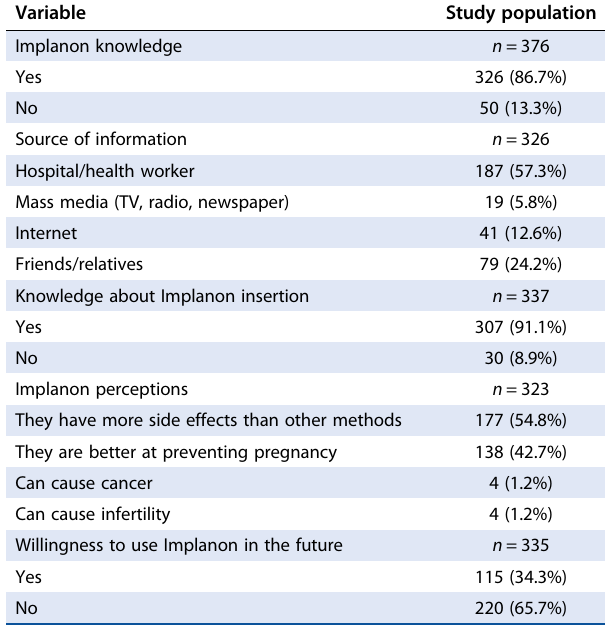
Table 4: Patient attitude towards and knowledge of Implanon use among study population at a district hospital and PHC clinics between